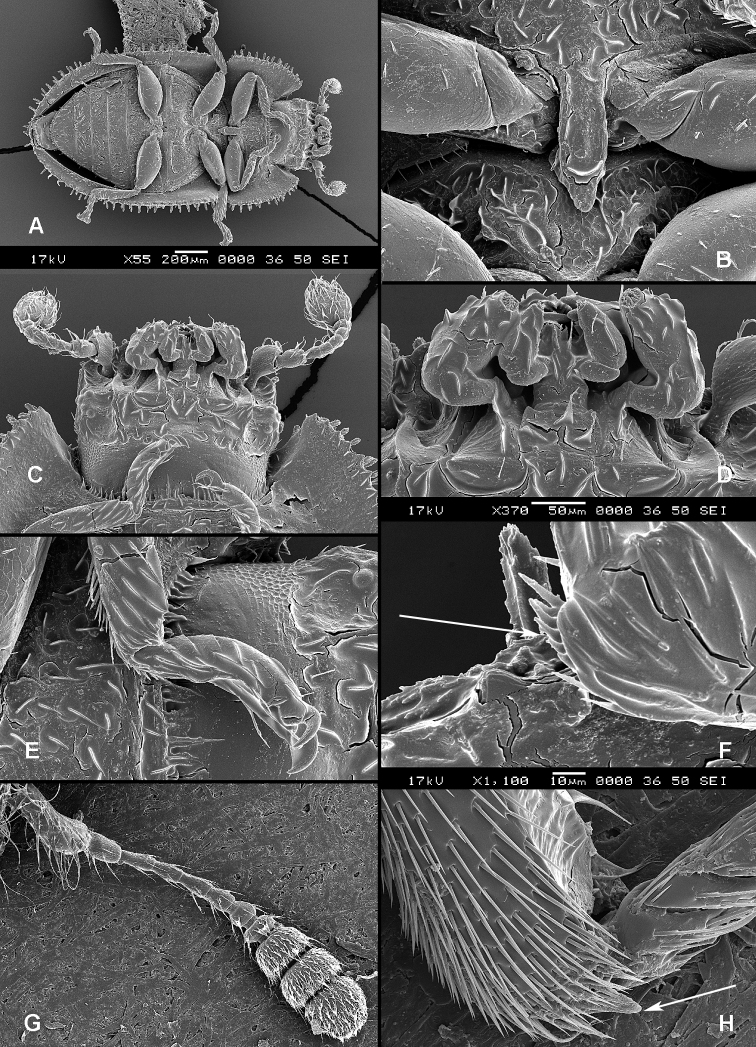
A–F
Colydiopeltis compactum (A ventral surface B procoxal area C head ventrally D detail of mouthparts E protarsus F apex of metatibia with row of spines) G–H
Thymalus limbatus (G antenna H apex of protibia with straight spur).